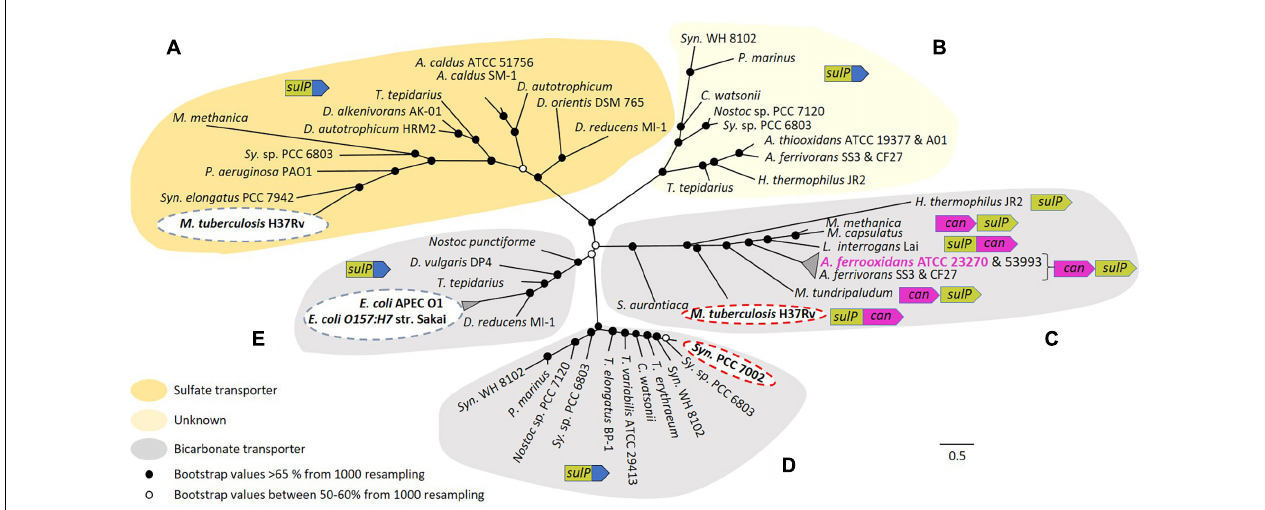
FIGURE 4 | Maximum likelihood unrooted phylogenetic tree of SulP annotated as a sulfate (orange background), bicarbonate transporter (gray background) or of unknown function (light yellow background). (A–E) Refer to five phylogenetically distinct clades of sulfate or bicarbonate transporters. Bootstrap values between 50–60% (from 1000 resampling) are shown by white circles and bootstrap values > 65% (1000 resampling) are represented by black circles. Arrows indicate genes where green = sul P, purple = can and blue = STAS domain. Abbreviations for species names: A. caldus , Acidithiobacillus caldus; A. thiooxidans , Acidithiobacillus thiooxidans; A. ferrivorans , Acidithiobacillus ferrivorans; A. ferrooxidans , Acidithiobacillus ferrooxidans; C. watsonii , Crocosphaera watsonii ; D. alkenivorans AK-01, Desulfatibacillum alkenivorans AK-01; D. autotrophicum HRM2, Desulfobacterium autotrophicum HRM2; D. orientis DSM 765, Desulfobacterium orientis DSM 765; D. reducens MI-1, Desulfobacterium reducens MI-1; D. vulgaris DP4, Desulfovibrio vulgaris DP4; E. coli APEC O1, Escherichia coli APEC O1; E. coli O157:H7 str. Sakai, Escherichia coli O157:H7 str. Sakai; H. thermophilus JR2, Hydrogenovibrio thermophilus JR2; L. interrogans Lai, Leptospira interrogans Lai; M. capsulatus